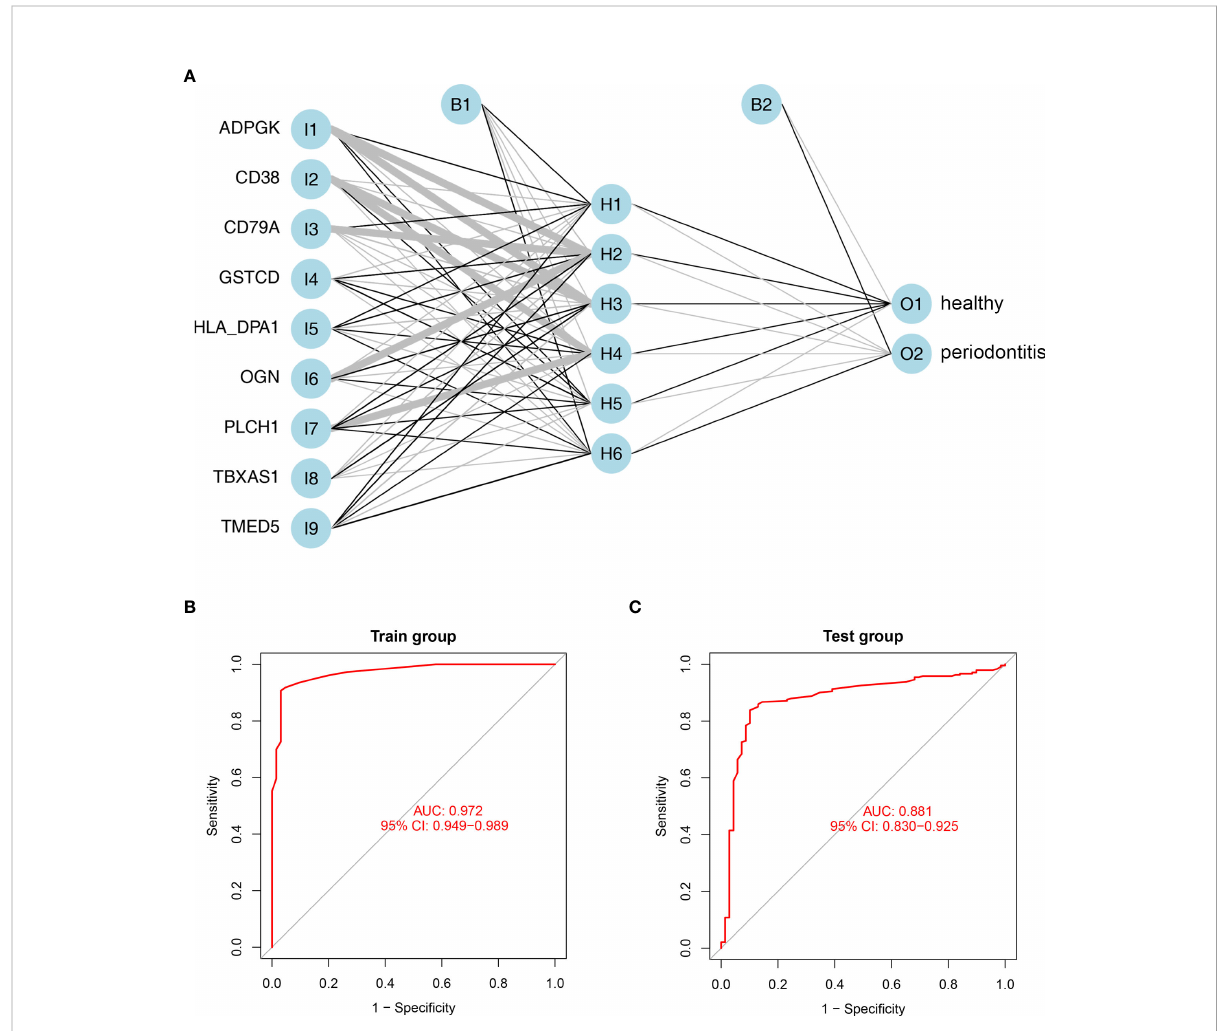
FIGURE 6 Establishment and validation of arti fi cial neural networks. (A) Results of neural network visualization based on the expression of nine hub genes. Linewidths of connectors represent the weights: the wider the line is, the heavier the weight is. O1: healthy group; O2: periodontitis group. (B, C) ROC curves for the 9 hub DEGs in the training cohort (B) and validation cohort (C) by the fi ve-time cross-validation model. AUC, area under the